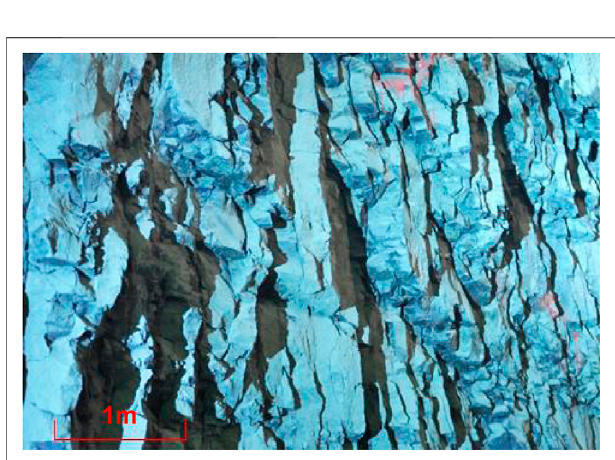
FIGURE 3 | Columnar jointed basalt in diversion